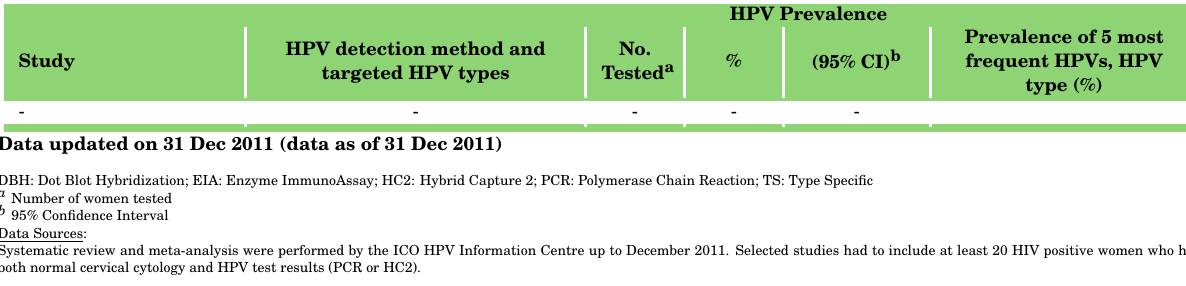
Table 24: Studies on HPV prevalence among HIV+ women with normal cytology in Peru